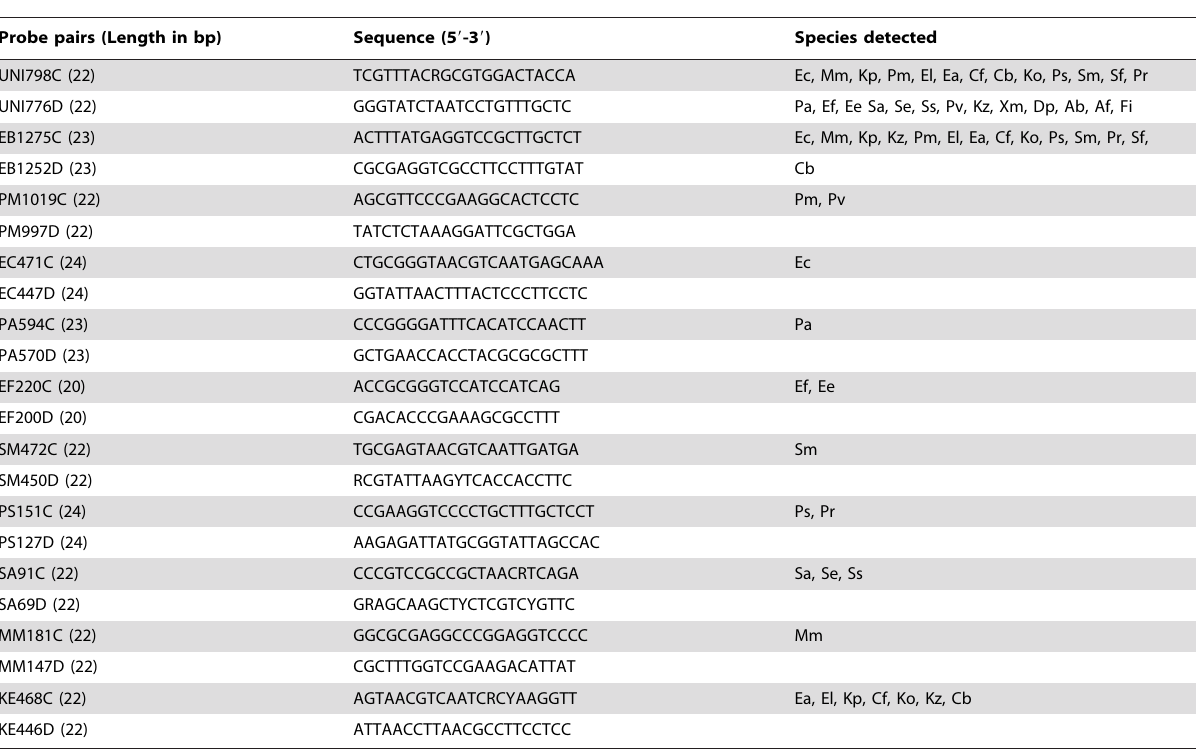
Table 1. Sequences of the oligonucleotide probes used in this study.